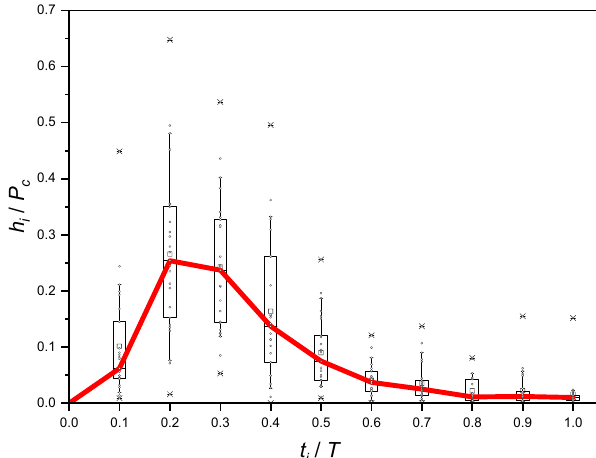
Figure 10. Dimensionless “reference” hyetograph for 25 precipitation (with T ≤ 180 min) with box charts with measurement results.